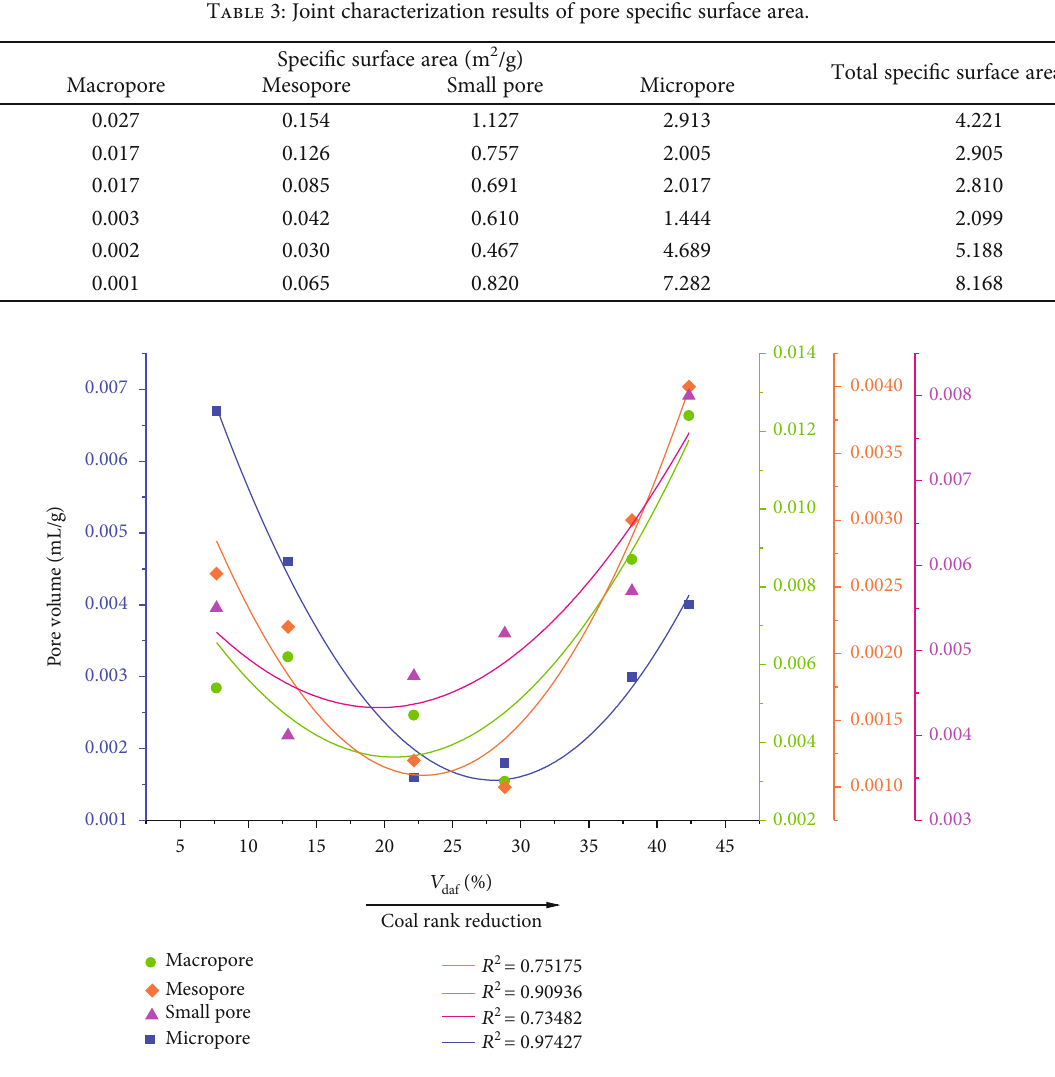
Figure 11: Curves of fi tting between volatile matter content and pore